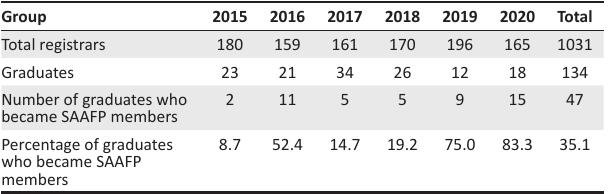
TABLE 2: National overview of registrars who became South African Academy of Family Physicians members after graduation.